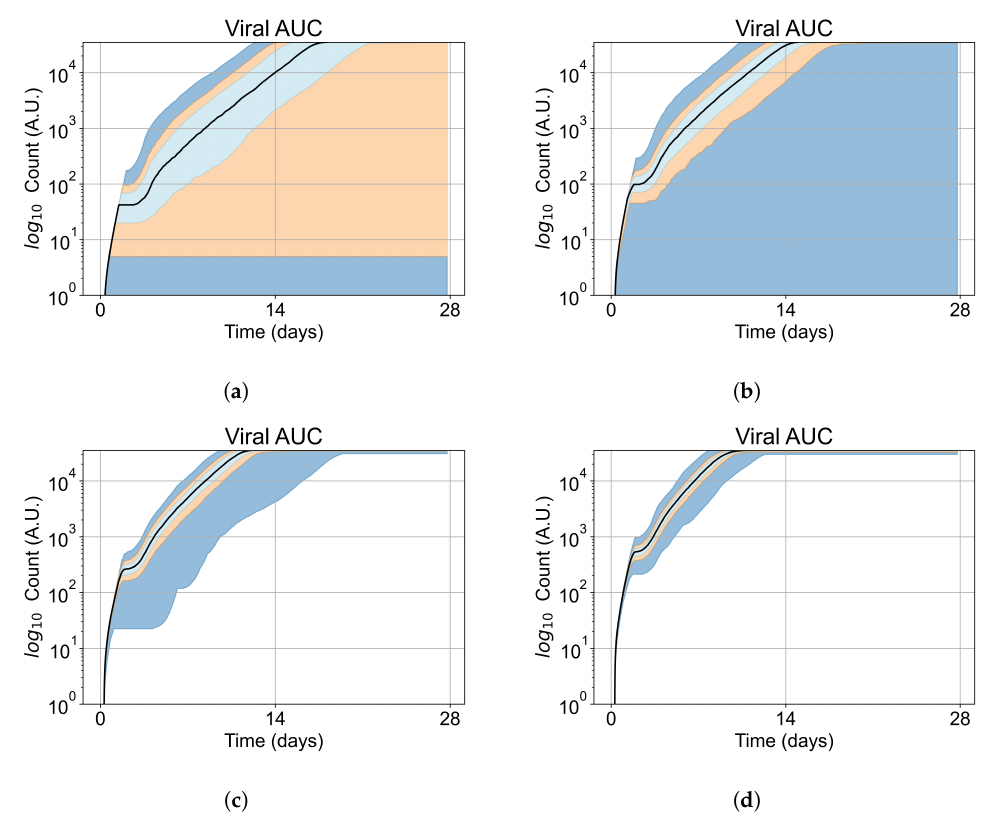
Figure A4. Extracellular viral AUC for 400 replicas of Sego et al.’s model performed by us [24], y-axis in log scale. In all the cases, the medians of simulation replicas are in black lines, the 0th to 100th quantiles are shaded as dark blue, 10th to 90th shaded in orange, and the 25th to 75th as light blue. ( a ) Simulations start with 1 initially infected cell and 7 simulations result in failure to infect (1.75% of replicas), the 90th quantile includes the upper bound of the number of cells. ( b ) Simulations start with 2 initially infected cells where 5 simulations result in failure to infect (1.25%), the 100th quantile includes the upper bound of the number of cells. ( c ) Simulations start with 5 initially infected cells. ( d ) Simulations start with 10 initially infected